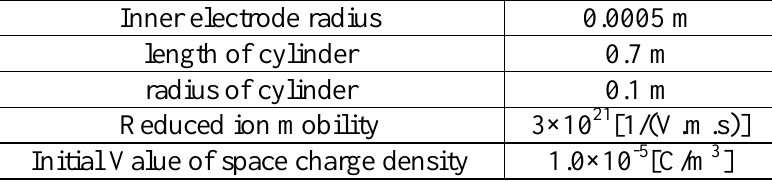
Table 2: Input parameters of model.